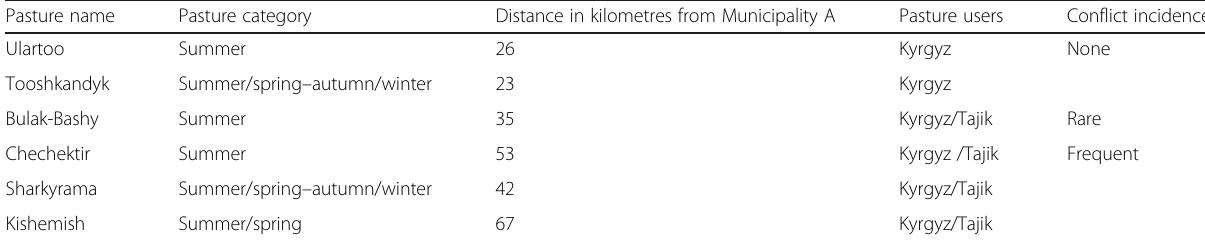
Table 2 List of summer pastures in the vicinity of the Municipality A and Municipality B communities Pasture name